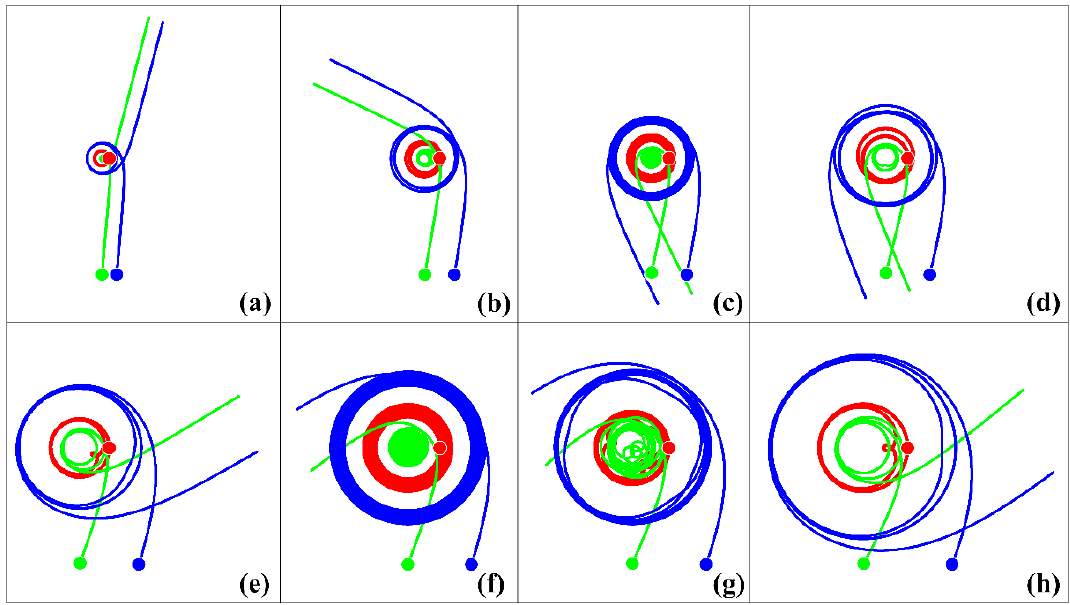
Figure 4. The trajectories of the two-layer point vortex structures when an intrathermocline pair runs into a surface cyclone at 𝐵 = −16 ; 𝛬 21 𝛬 11 ⁄ = 1 2⁄ ; and ( a ) 𝐿 = 1.0 , ( b ) 𝐿 = 2.0, ( c ) 𝐿 = 2.4, ( d ) 𝐿 = 3.0, ( e ) 𝐿 = 4.0, ( f ) 𝐿 = 4.3, ( g ) 𝐿 = 5.0, and ( h ) 𝐿 = 6.0.